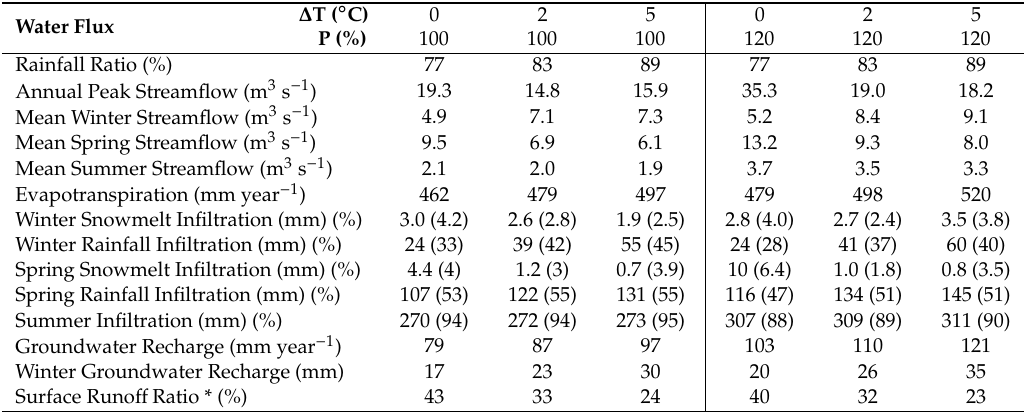
Table 4. Mean annual catchment scale water fluxes for the selected climate change scenarios. For the reference period, the mean annual temperature is 7.2 ◦ C and mean annual precipitation is 1030